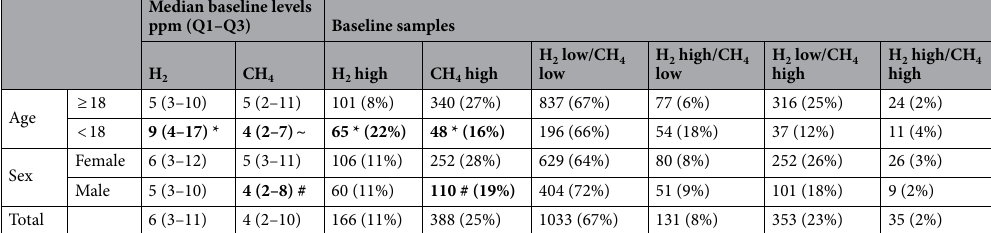
Table 1. Baseline H 2 and CH 4 levels according to age and sex of patients, indicated as median and interquartile range (Q1–Q3) is shown in a bracket. Baseline samples classification according to H 2 and CH 4 levels compared to their corresponding cut-offs. H 2 high means ≥ 20 ppm, CH 4 high means ≥ 10 ppm, H 2 low means < 20 ppm and CH 4 low means < 10 ppm. Comparing with patients above 18 years, * represents p < 0.01 and ~ represents p < 0.05. # represents p < 0.01 compared with female patients.